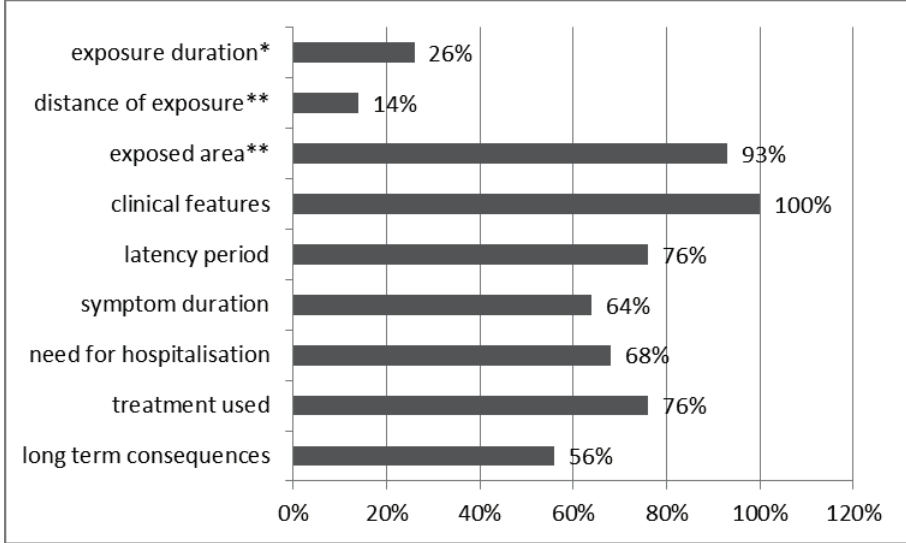
Figure 2. How often case reports report basic elements of exposure and clinical effects related to